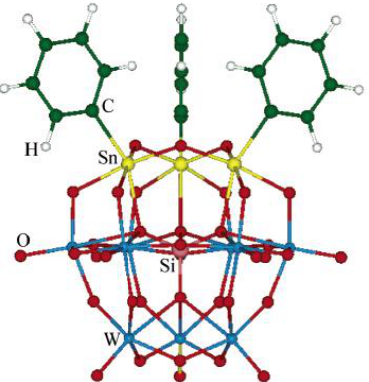
Figure 41. Theoretical studies of polyoxotungstate-R 3 Sn for the prediction of second-order NLO response. (Reprinted with permission from [72], Guan, W.; Yang, G.; Yan, L.; Su, Z. Prediction of second-order optical nonlinearity of trisorganotin- substituted β-Keggin polyoxotungstate. Copyright 2006 American Chemical Society.)